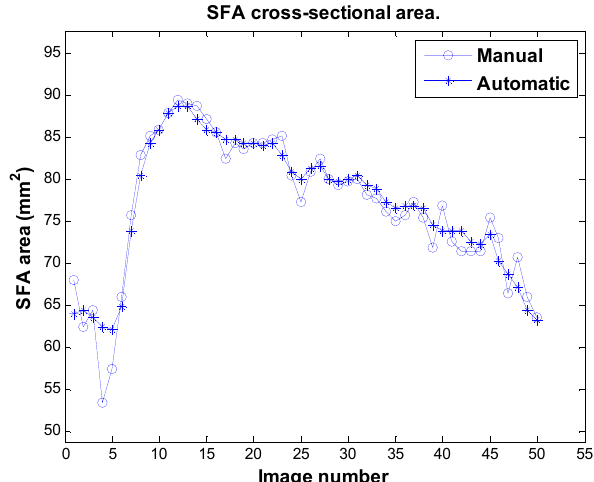
Figure 11. The cross-sectional SFA area changing in time (sequence no. 9). The unit in the y-axis is mm 2 . The x-axis unit is image